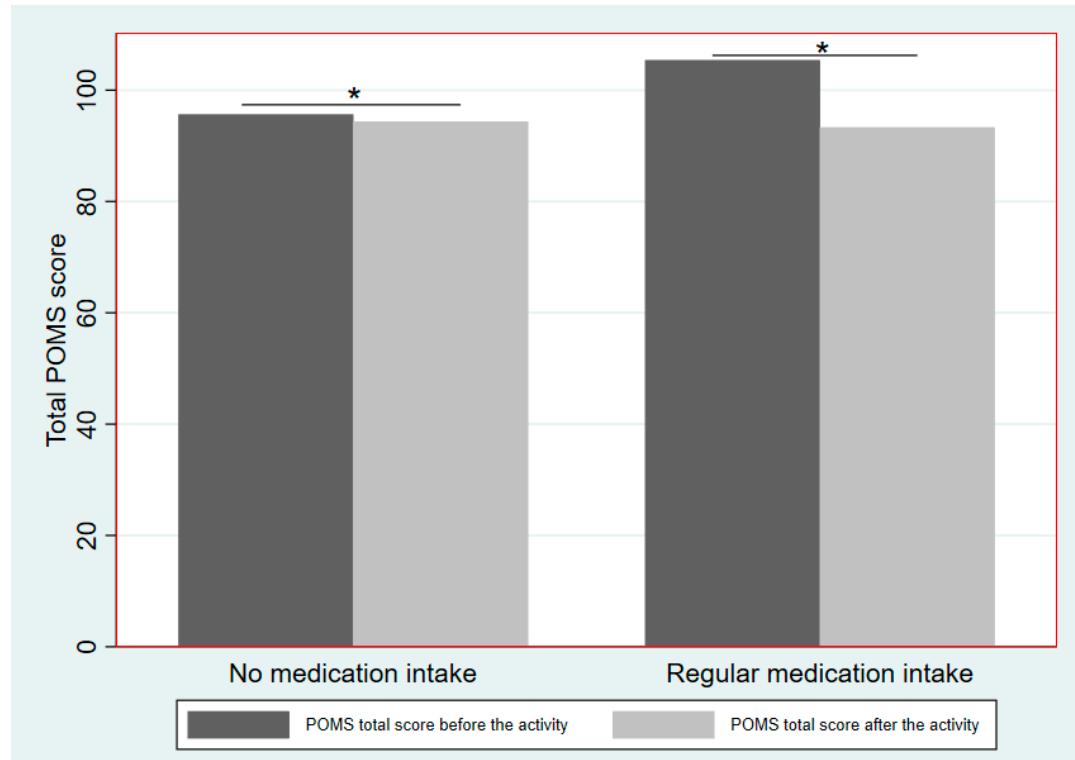
Figure 2. Differences between Profile of Mood States (POMS) total scores according to regular medication intake (yes, no), grouped by medication. * p <